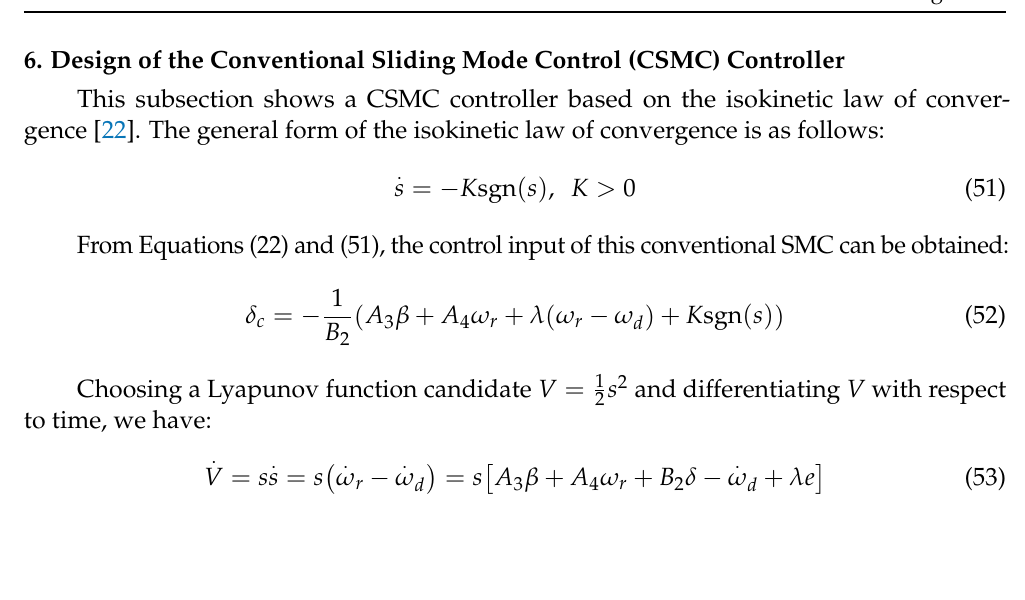
Table 2. Parameters of MPC algorithm. Parameters Values Comments N p 30 Predicted step size N c 60 Control step Row 10 Relaxation factor